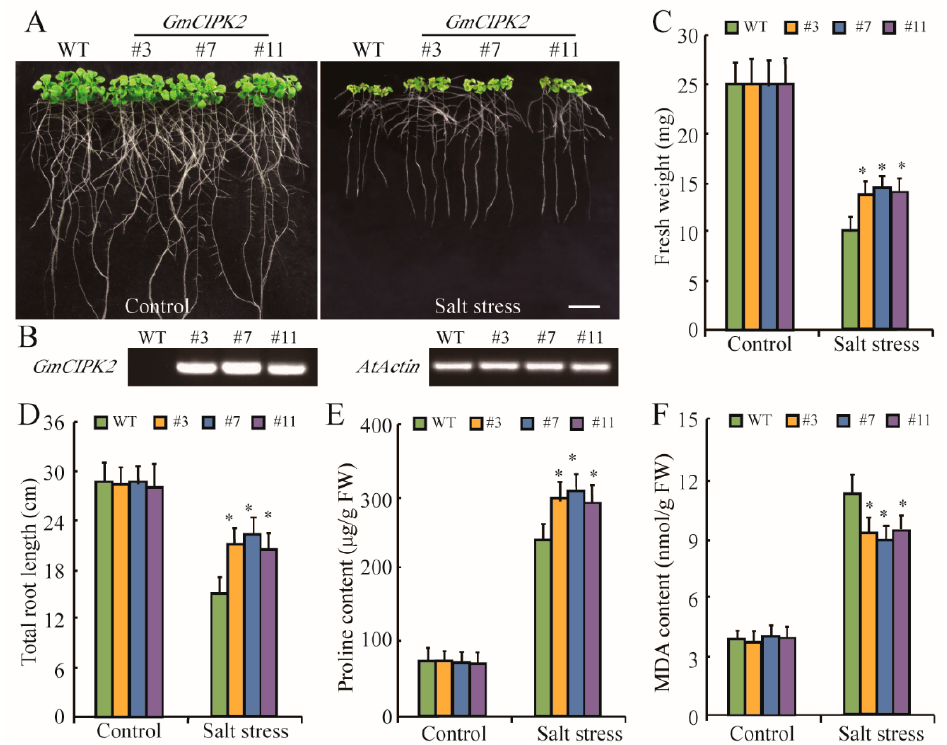
Figure 2. GmCIPK2 overexpression results in transgenic- Arabidopsis -enhanced salt tolerance. ( A ) Analyses of the salt tolerance in OE and WT Arabidopsis plants. Bar = 1 cm. ( B ) The transcript of GmCIPK2 was determined using semi RT-PCR assays. ( C ) Fresh weight, ( D ) total root length, ( E ) proline contents, and ( F ) MDA contents in OE and WT Arabidopsis plants under salt conditions. Each data point represents the mean (±SE) of three independent biological replicates. The * represents significant differences with the corresponding controls (* p < 0.05).